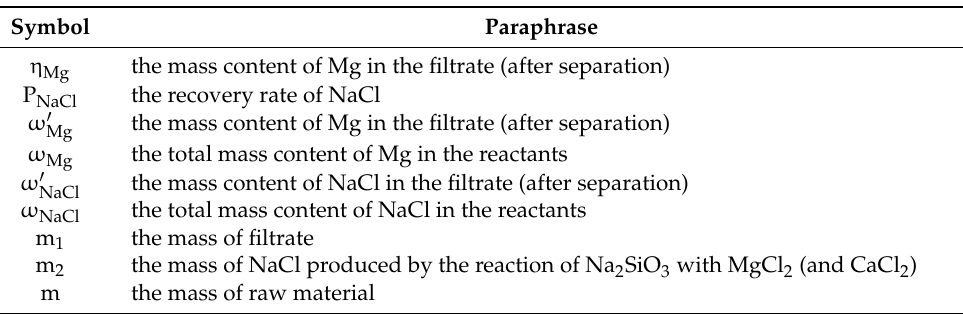
Table 3. The parameters in the Equations (1) and